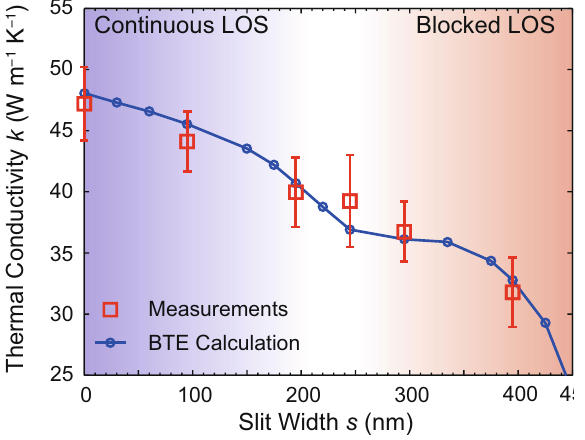
Figure 3. Thermal conductivity k of the nanostructured silicon samples with varying slit width s . The blue solid line is a model prediction that is obtained by solving Boltzmann Transport